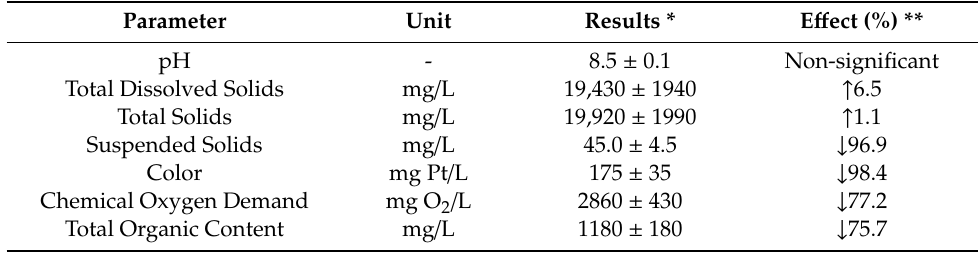
Table 6. Selected physicochemical parameters of treated tannery wastewater after TM application.